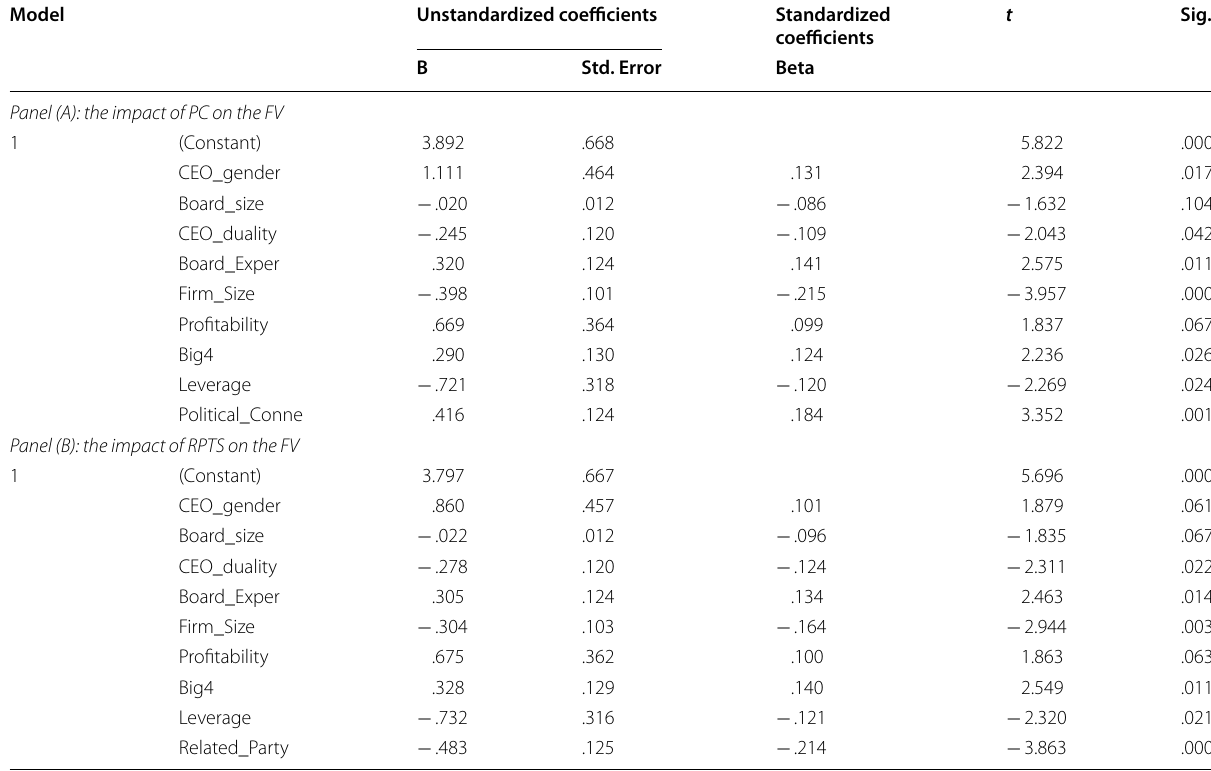
Table 4 Regression results Model